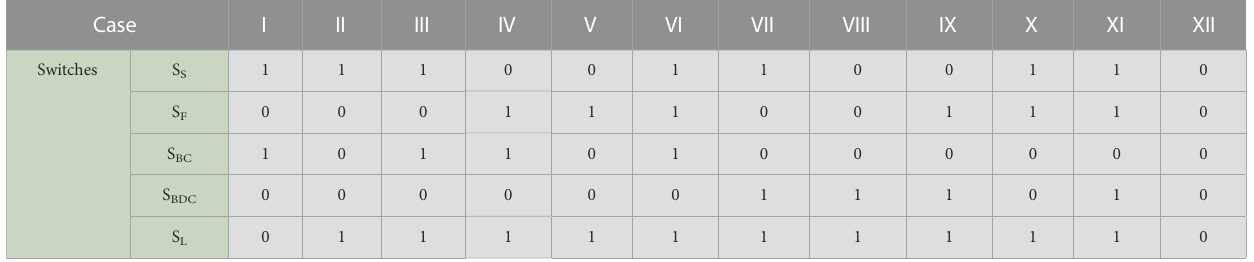
TABLE 1 Switching pattern.